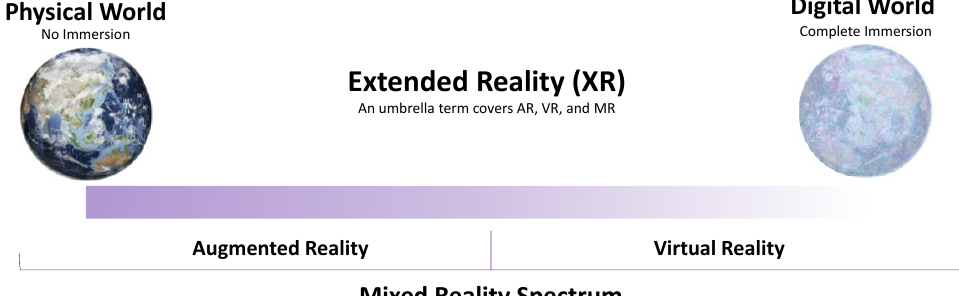
Figure 5. The mixed reality spectrum.